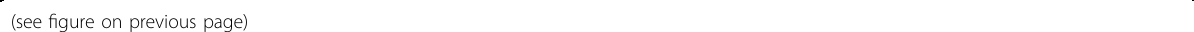
Fig. 6 Drug-resistant cell-derived exosomal EphA2 promotes breast cancer progression through ERK signaling. a Gene set enrichment analysis (GSEA) showed that the expression of EphA2 signi fi cantly correlated with the MAPK signaling pathway based on the TCGA database. b Western blotting analysis of the expression total and phosphorylated Erk1/2, total and phosphorylated Akt, and total and phosphorylated STAT3 in two breast cancer cells treated with exosomes for 24 and 48 h. c Western blotting analysis of the expression of total and phosphorylated Erk1/2 in two breast cancer cells treated with EphA2-rich exosomes derived from HEK-293T cells for 24 h. β -actin was used as the loading control. d Exosomes from EphA2-stable silenced drug-resistant cells failed to induce an elevation of ERK1/2 phosphorylation. e DR-Exos failed to induce an upregulation of phosphorylated ERK1/2 in Ephrin A1 knockdown cells compared with control cells. f Exosomal EphA2 and its mutants EphA2- Δ S could induce upregulation of phosphorylated ERK1/2, whereas exosomal EphA2- Δ L failed to induce ERK1/2 phosphorylation. g Exosomal EphA2 or its mutants cannot induce an increase in ERK1/2 phosphorylation in Ephrin A1 knockdown cells. h PD98059 eliminated the phosphorylation of ERK after incubation with exosomes. i Inhibition of ERK signaling by PD98059 decreased the migration ability of breast cancer cells treated with DR-Exos. All experiments were repeated at least three times. **** P < 0.0001 and ns P > 0.05 indicate no statistical signi fi cance. j Exosomes carrying EphA2 and EphA2- Δ S failed to induce an upregulation of phosphorylated ERK1/2 in the presence of PD98095 compared with control cells. k PD98059 blocked the migratory promoting effect of exosomes carrying EphA2 and EphA2- Δ S. All experiments were repeated at least three times. **** P < 0.0001 and ns P > 0.05 indicate no statistical signi fi cance. Scale bars: 200 μ